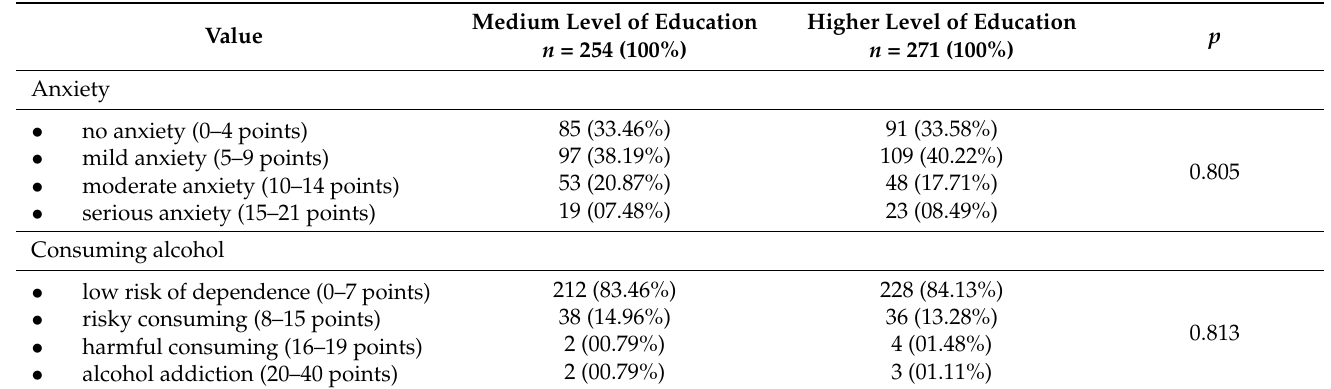
Table 7. Statistical differences between the study groups divided by level of education in terms of anxiety and the level of alcohol consumption after obtaining normalized results.